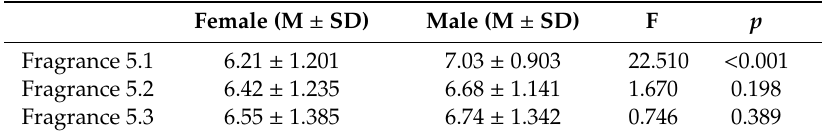
Table 7. Means (M), standard deviation (SD), and univariate e ff ects of the fragrances by gender.